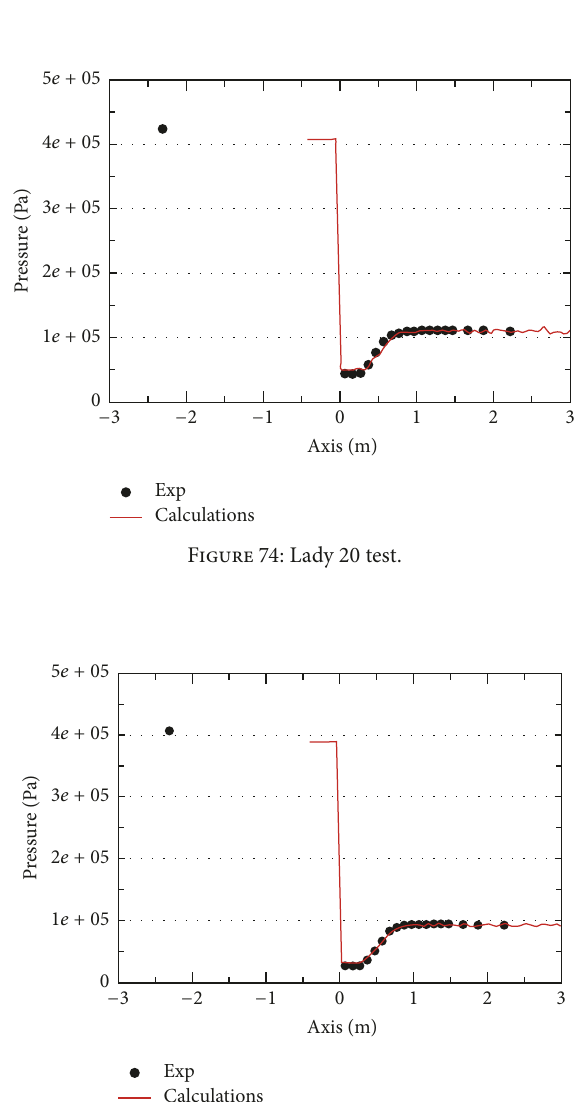
Figure 75: Lady 21 test (see Figure